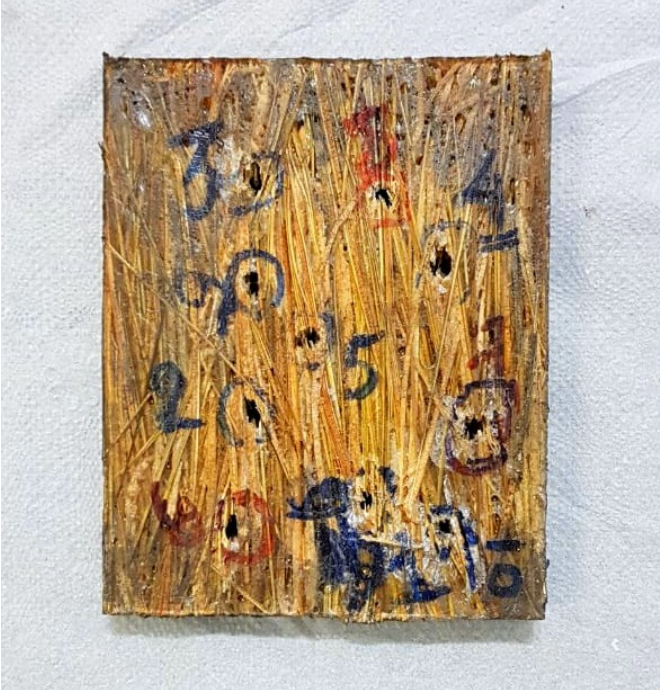
Figure 7. Target subjected to ballistic impact 30 vol% epoxy-caranan fibers composites.